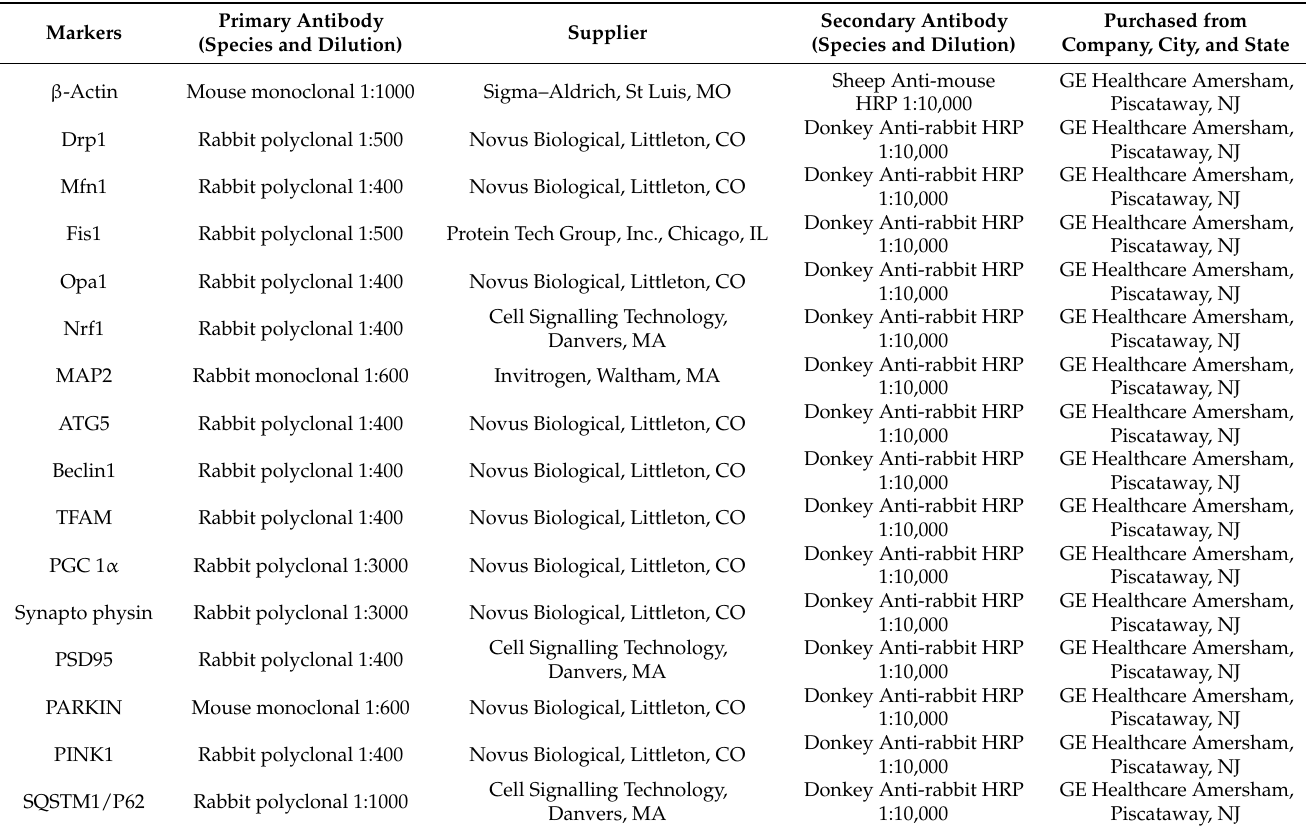
Table 2. Summary of the antibody dilutions and conditions used in the immunoblotting analysis of mitochondrial dynamics, mitochondrial biogenesis, synaptic, autophagy, and mitophagy proteins in the control, TH, and TH + chaya